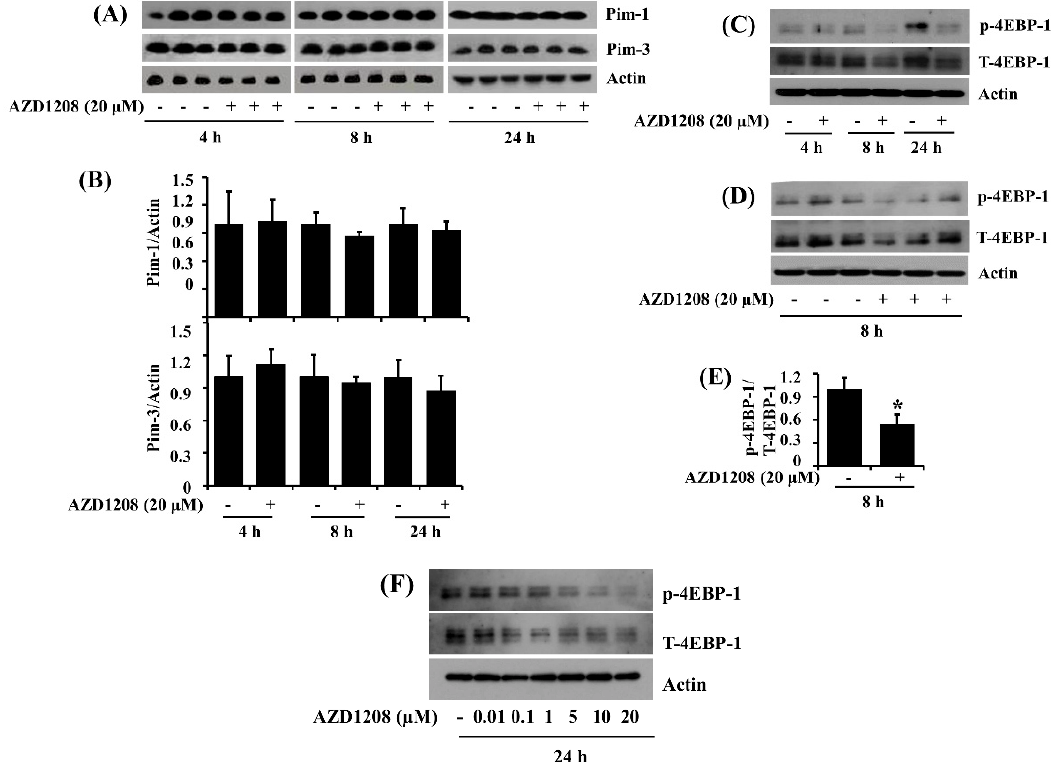
Figure 7. Effect of AZD1208 on expression and/or phosphorylation of Pim kinases and 4EBP-1 in 93T449 cells. ( A ) 93T449 cells were treated with AZD1208 (20 µM) or vehicle control (DMSO) in